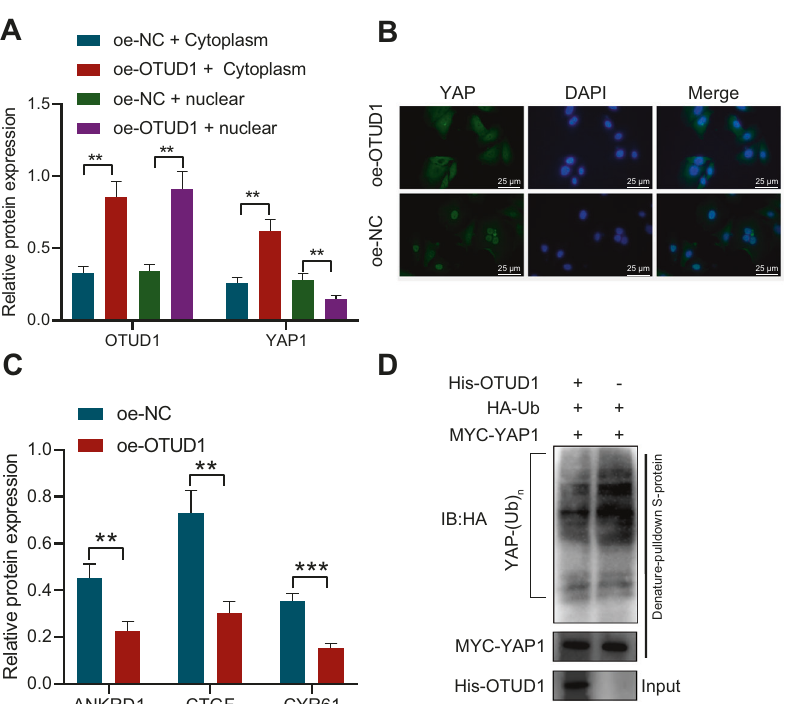
Fig. 4 OTUD1 arrests nuclear translocation of YAP1 through deubiquitination and reduces the activity of YAP1. A Western blot analysis of YAP1 protein in the nucleus and cytoplasm of PC-9/ER cells overexpressing OTUD1. B Immuno fl uorescence detection of YAP1 localization in the PC-9/ER cells overexpressing OTUD1. C Western blot analysis of ANKRD1, CTGF and CYR61 proteins in PC-9/ER cells overexpressing OTUD1. D Ubiquitination level of YAP1 in PC-9/ER cells overexpressing OTUD1 detected by Co-IP assay. ** p < 0.01, *** p < 0.001. Data are shown as mean ± standard deviation of three technical replicates. Data between two groups were compared by unpaired t